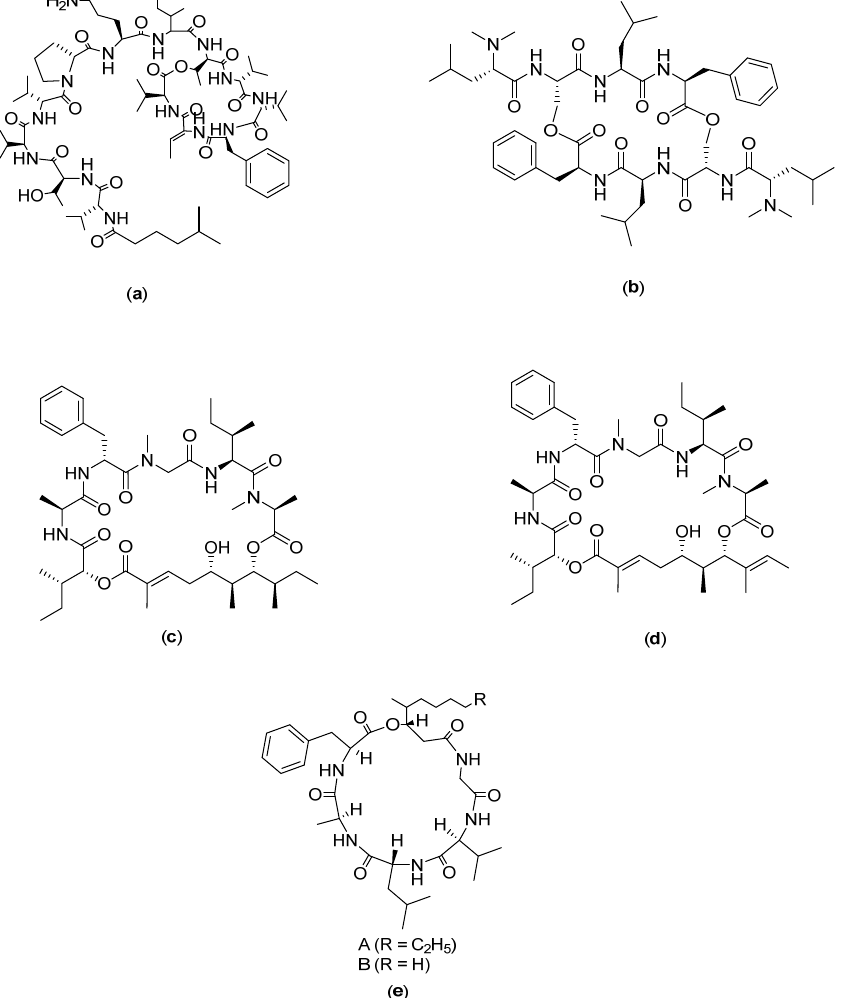
Figure 7. Structure of: ( a ) Kahalalide F; ( b ) IB-01212; ( c ) Lagunamides A; ( d ) Lagunamides B; and ( e ) Scopularides. IB-01212 (Figure 7b) is an isolate obtained from mycelium extract of Clonostachys sp . ESNA-A009. Compound IB-01212 is a cyclodepsipeptide compound which has structures as a cyclic dimer formed by two LN chains, N-Me2Leu-L-Ser-LN -MeLeu-LN-MePhe and bound by two esters formed between asPa the hydroxyl functional group of L-Ser. This compound has been tested in vitro on 14 different human tumor cell lines and it is most active against LN-caP (prostate cancer), SK-BR3 (breast cancer), HT29 (colon cancer), and HELA (cervical cancer), with GI 50 (growth inhibition) values in the order of 10 − 8 M [49]. Lagunamides A and B (Figure 7c,d) are cyclic depsipeptides isolated from the fila- mentous marine cyanobacterium, Lyngbya majuscula , from Hantu Island, Singapore. Pre- vious studies tested lagunamides A and B on several cancer cell lines, namely, BJ, BJ shp53, P388, A549, PC3, and SK-OV3, from which the cytotoxicity of lagunamide A was demonstrated on P388 (IC 50 : 6.4 µg/mL), A549 (IC 50 : 2.9 µg/mL), PC3 (IC 50 : 2.5 µg/mL), and